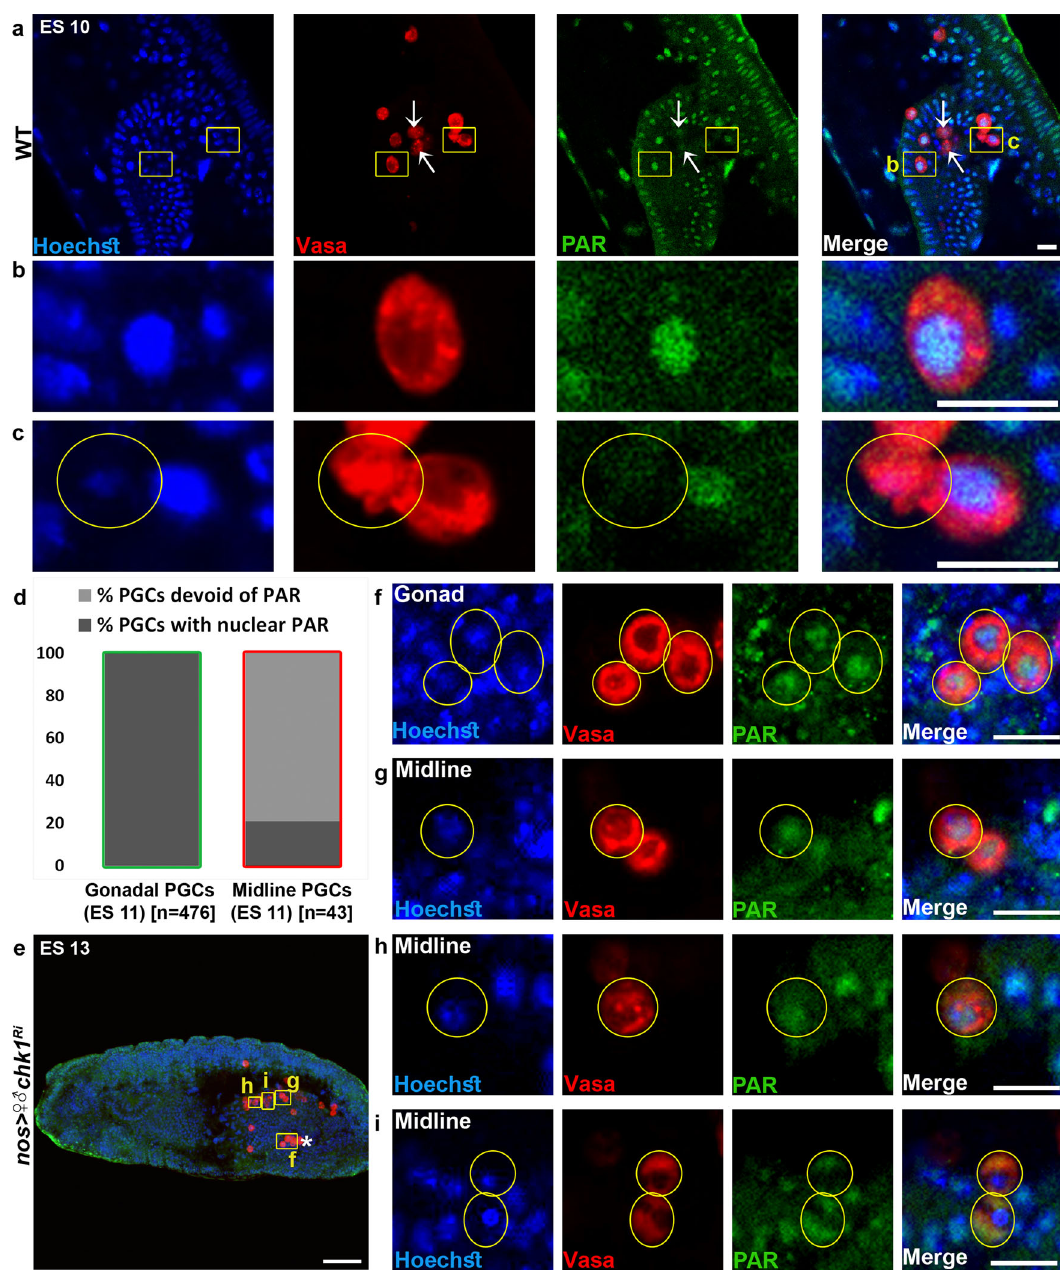
Fig. 9 PAR polymers are released to the cytoplasm during PGC death. a – d Dying PGCs display no PAR polymers in the nucleus. A representative image of the midline region of an ES 10 WT embryo stained to visualize PAR (anti-PAR; green), PGCs (Vasa; red), and DNA (Hoechst; blue) ( a ), and magni fi cations of the areas outlined by yellow rectangles ( b , c ). Arrows are pointing at two dying PGCs with highly reduced levels of nuclear PAR. Note that the PAR polymers are predominantly localized in the nucleus of living (intact) PGCs, but are almost absent in dying PGCs (a condensed dying PGC is circled). Scale bars, 10 μ m. Quanti fi cation of the percentage of gonadal and midline PGCs devoid of PAR signal or with nuclear PAR in WT ES 11 embryos ( d ). Green column outline indicates intact living cells, while red column outline indicates condensed and distorted dying PGCs. n number is shown in brackets where n = number of examined PGCs. e – i Ectopically surviving PGCs due to compromised DDR reveal the release of the PAR polymers from the nucleus to the cytoplasm. Shown is a representative image of an ES 13 embryo with PGC-speci fi c chk1 knockdown ( e ) stained as in ( a ). An asterisk indicates gonadal PGCs. Magni fi cations of several areas outlined by yellow rectangles in ( e ) are presented in ( f – i ). Shown are gonadal PGCs ( f ) and an ectopically surviving midline PGC ( g ) predominantly displaying PAR in the nucleus (circled), an ectopically surviving midline PGC displaying both nuclear and cytoplasmic PAR ( h ; circled), and ectopically surviving midline PGCs displaying only cytoplasmic PAR ( i ; circled). Scale bars in e 50 μ m, f – i 10 μ